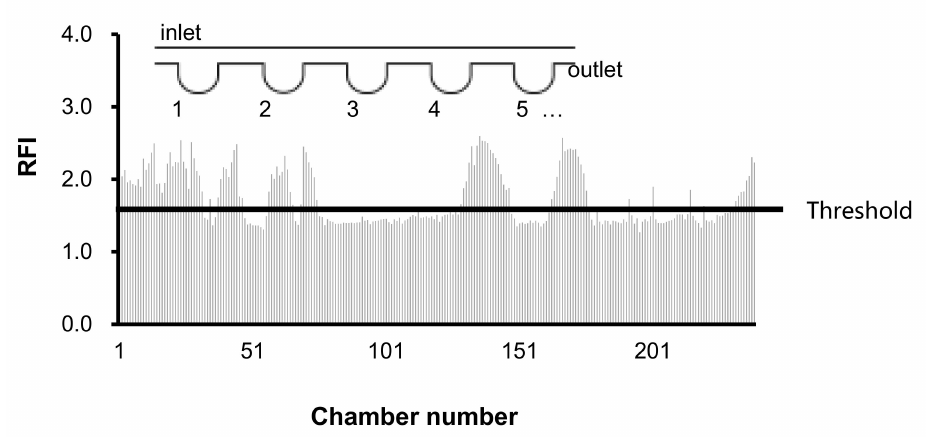
Figure 5. Detection of S. enterica by PCR on the microfluidic disc.